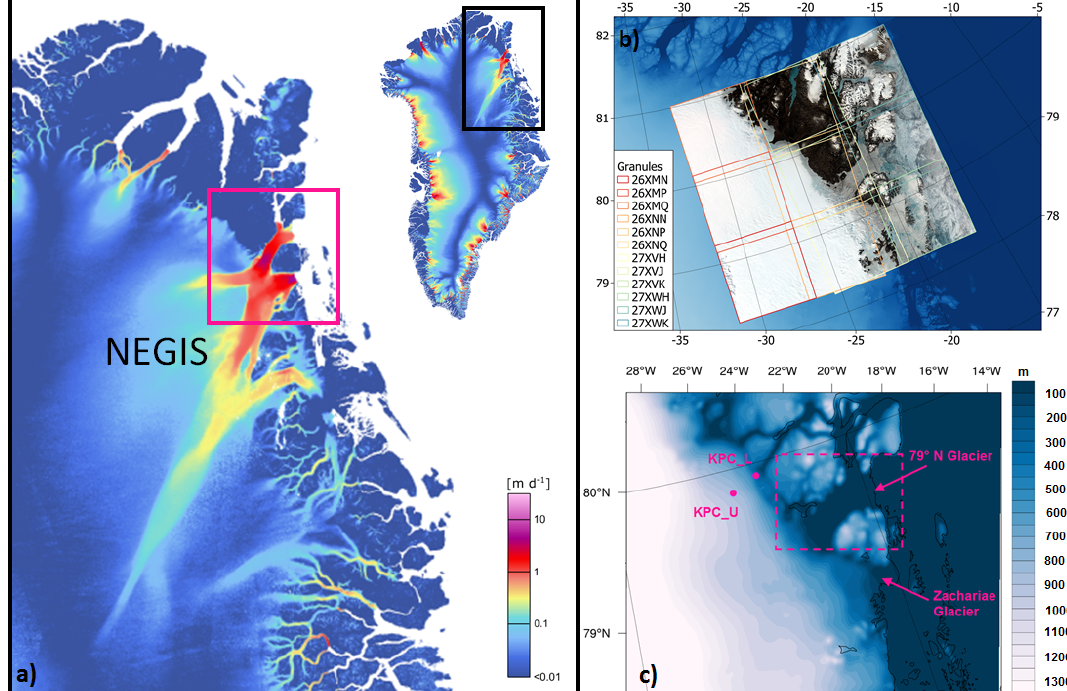
Figure 1. (a) Ice velocity (md − 1 ) of the north-east of Greenland with the North East Greenland Ice Stream (NEGIS) labelled (insert is the whole map of Greenland with ice velocities and a black box outlining the area in a ). Pink box outlines the approximate area of (b) and (c) . (b) The mosaic of Sentinel-2 granules used to apply the SGL detection algorithm, captured on 19 June 2019. The background is the GIMP DEM of Howat et al. (2014). (c) The inner domain of Polar Weather Research and Forecasting (PWRF) model simulations by Turton et al. (2020), with the locations of the two AWSs (KPC_U and KPC_L) and the elevation of the glacier and ice sheet in colour. The dashed pink box highlights the floating portion of the glacier. Ice velocity data from Sentinel-1, winter campaign from December 2019 to January 2021, from the ESA Ice Sheets CCI project (http://products.esa-icesheets-cci.org/products/downloadlist/IV/, last access: 20 June 2021).